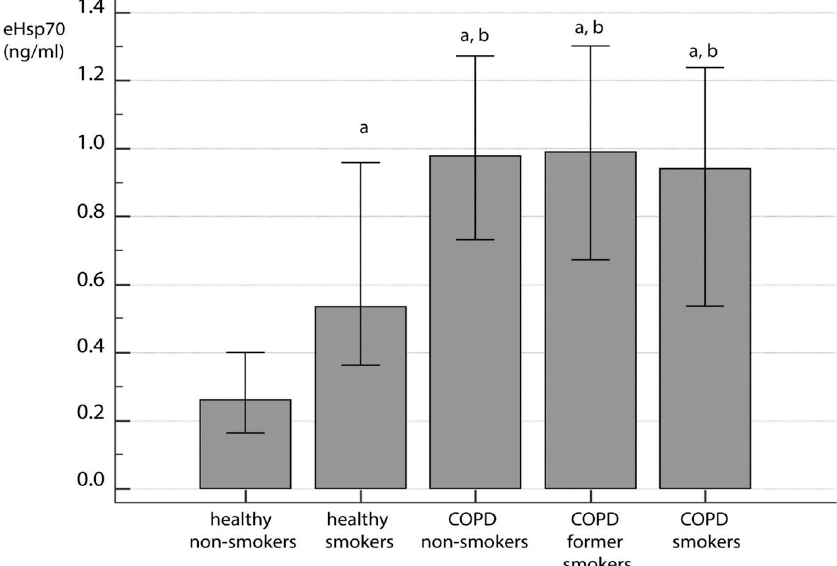
Figure 2. eHsp70 in healthy individuals and COPD patients regarding smoking status. All data were presented as median with interquartile range. Statistical analysis was performed by Kruskal-Wallis one-way analysis of variance on ranks. a statistically significant increase in eHsp70 concentration in comparison to healthy nonsmokers; b statistically significant increase in eHsp70 concentration in comparison to healthy smokers.